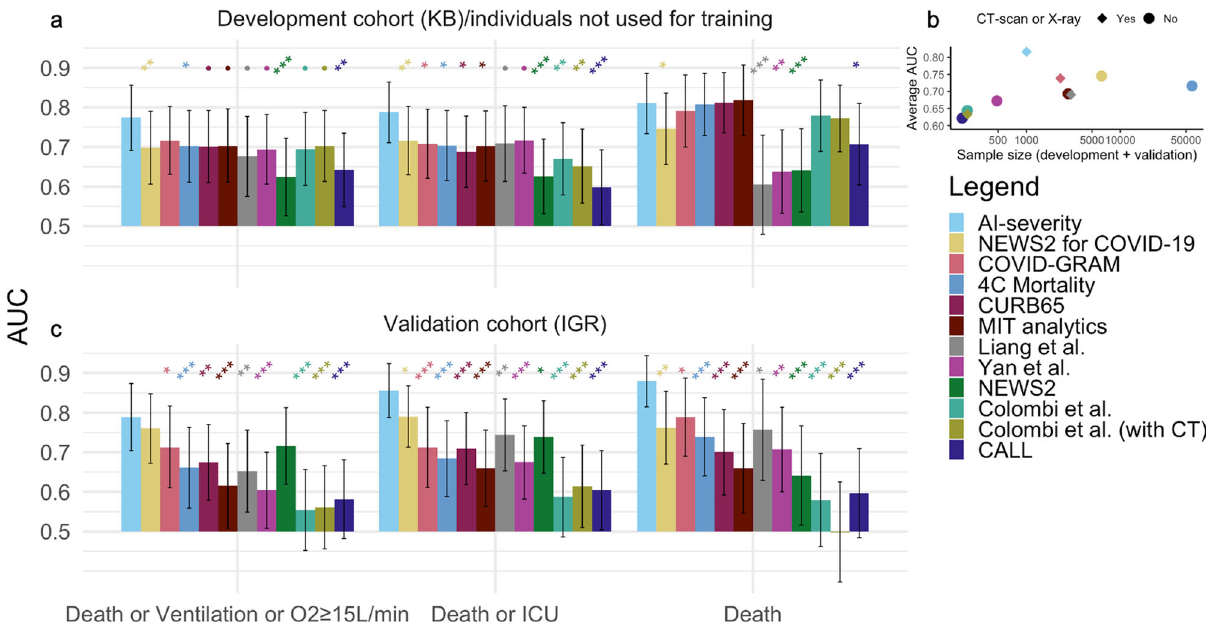
Fig. 2 AUC values when comparing AI-severity to other prognostic scores for COVID-19 severity/mortality. The AI-severity model was trained using the severity outcome de fi ned as an oxygen fl ow rate of 15 L/min or higher, the need for mechanical ventilation, or death. When evaluating AI-severity on the alternative outcomes, the model was not trained again. a AUC results are reported on the leftover KB patients from the development cohort (150 patients). b The mean AUC (averaged over outcomes and over hospitals) as a function of the sample size (sum of sample sizes for the development and validation cohorts) used to construct the score. c AUC results are reported on the external validation set from IGR (135 patients). Models are sorted from left to right (and from top to bottom in the legend) by decreasing order of AUC values (averaged over outcomes and over hospitals). Error bars represent the 95% con fi dence intervals obtained with the DeLong procedure. Stars indicate the order of magnitude of p -values for the DeLong one-sided test in which we test if AUC AI-severity > AUC other score , (cid:129) 0.05 < p ≤ 0.10, *0.01< p ≤ 0.05, **0.001 < p ≤ 0.01, *** p ≤ 0.001. KB Kremlin-Bicêtre hospital, IGR